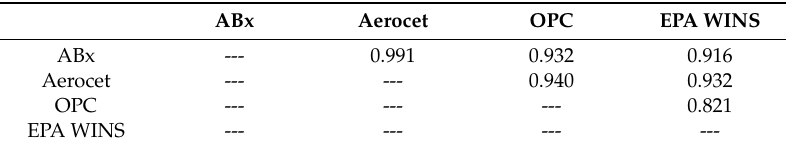
Table 6. Correlations between all instruments (8-h averaged data). All the correlations are significant at 0.001 level and results are based on 19 monitoring sessions. Spearman’s rank order correlation (rho) is reported in the table.